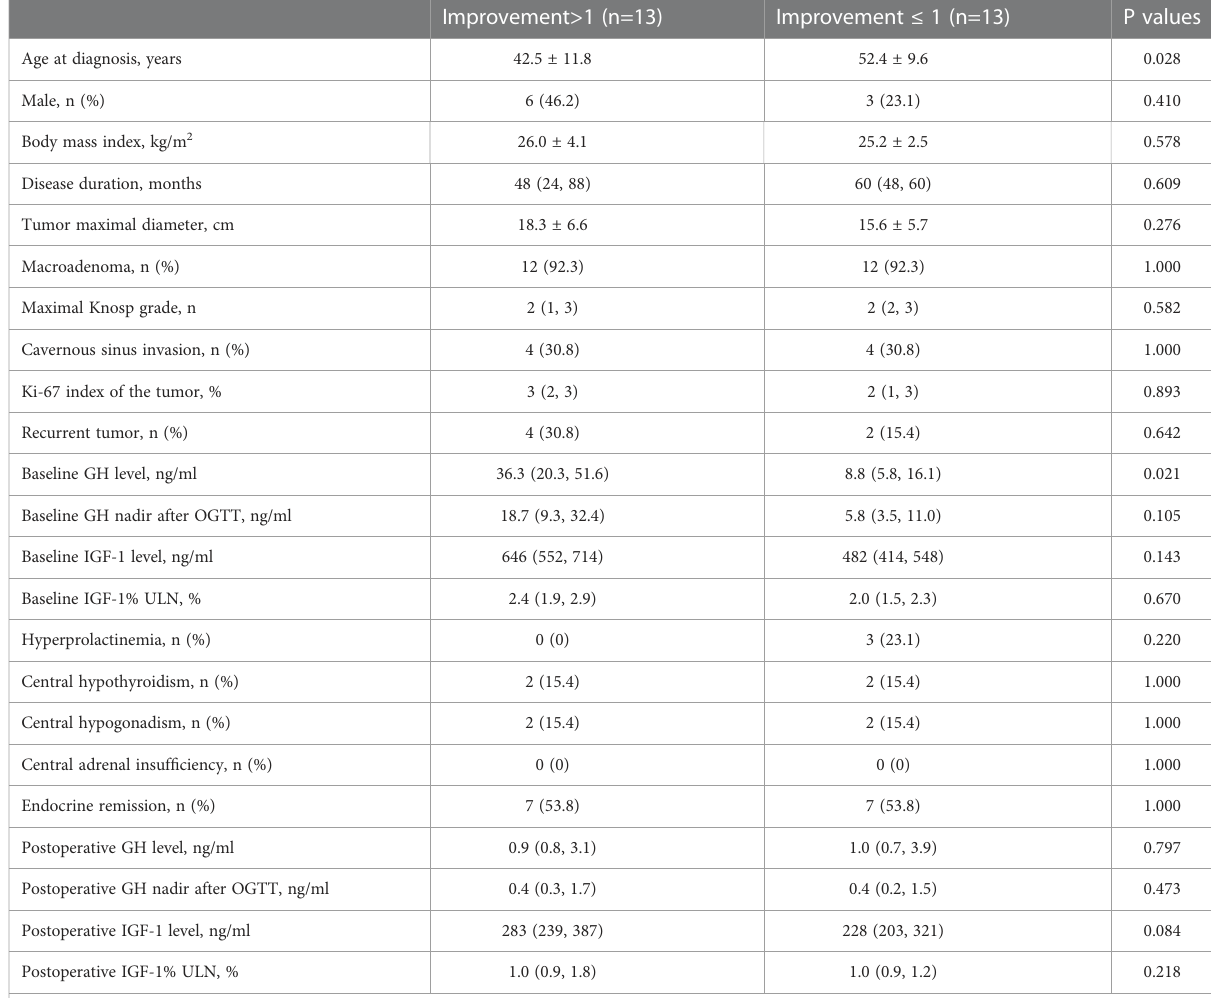
TABLE 3 Clinical relevance of postoperative skin lesion improvement (>1/ ≤ 1) in acromegaly. Improvement>1